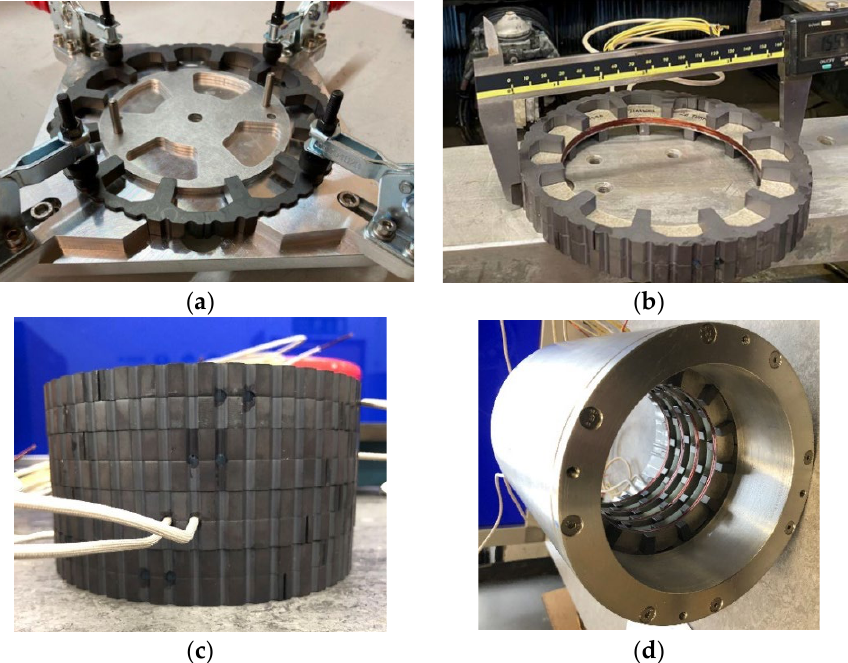
Figure 9. TFM stator construction: ( a ) alignment of stator segments together to form a full circular stator phase, ( b ) a modular stator phase with circumferential windings and mica slot liners, ( c ) me- chanical alignment (giving 90° electrical displacement) of axial TFM phases, ( d ) assembly of the stator with aluminum housing.